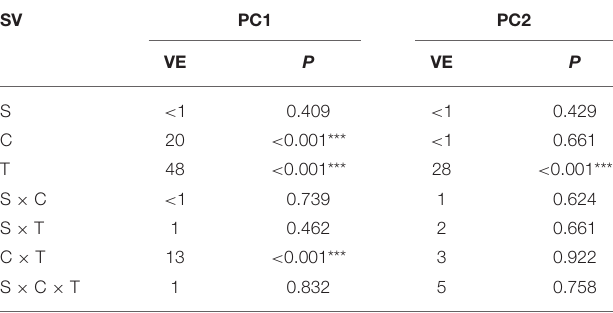
TABLE 6 | Multivariate analysis of variance (the three-way MANOVA) for the PC1 and PC2 based on the data of the DGGE indices for all of the sampling days as affected by the bacterial strain (S), concentration (C), time (T) and their interactions. SV